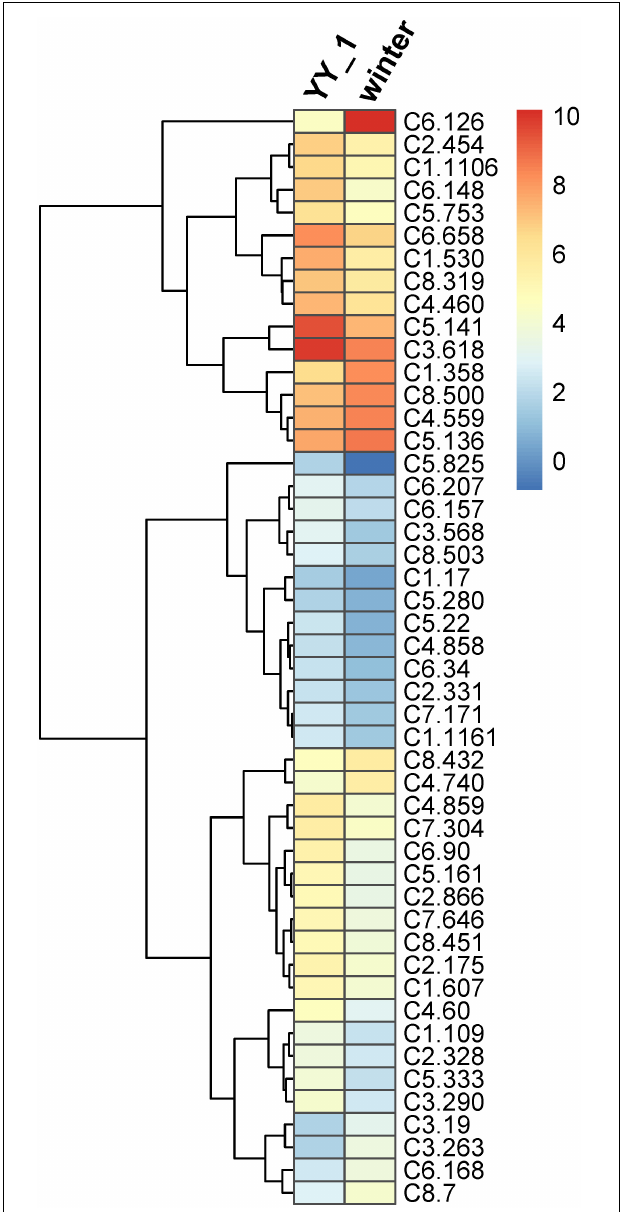
FIGURE 5 | Expression profile of transcription factor genes with differential transcription levels in the M. purpureus winter strain compared to those in the YY-1 strain. The tree is a dendrogram of the cluster analysis obtained by the hclust method in R, which is a hierarchical partitioning of data that visually resembles a heat map and reflects the gene expression values in different